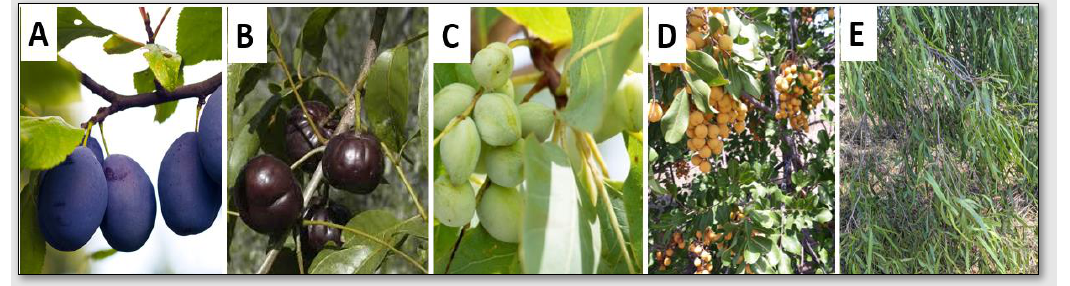
Figure 12. ( A ) Podocarpus elatus (Illawarra plum), ( B ) Pleiogynium timoriense (Burdekin plum), ( C ) Terminalia ferdinandiana (Kakadu plum), ( D ) Cupaniopsis anacardioides (Tuckeroo) and ( E ) Pit- tosporum angustifolium (Gumbi